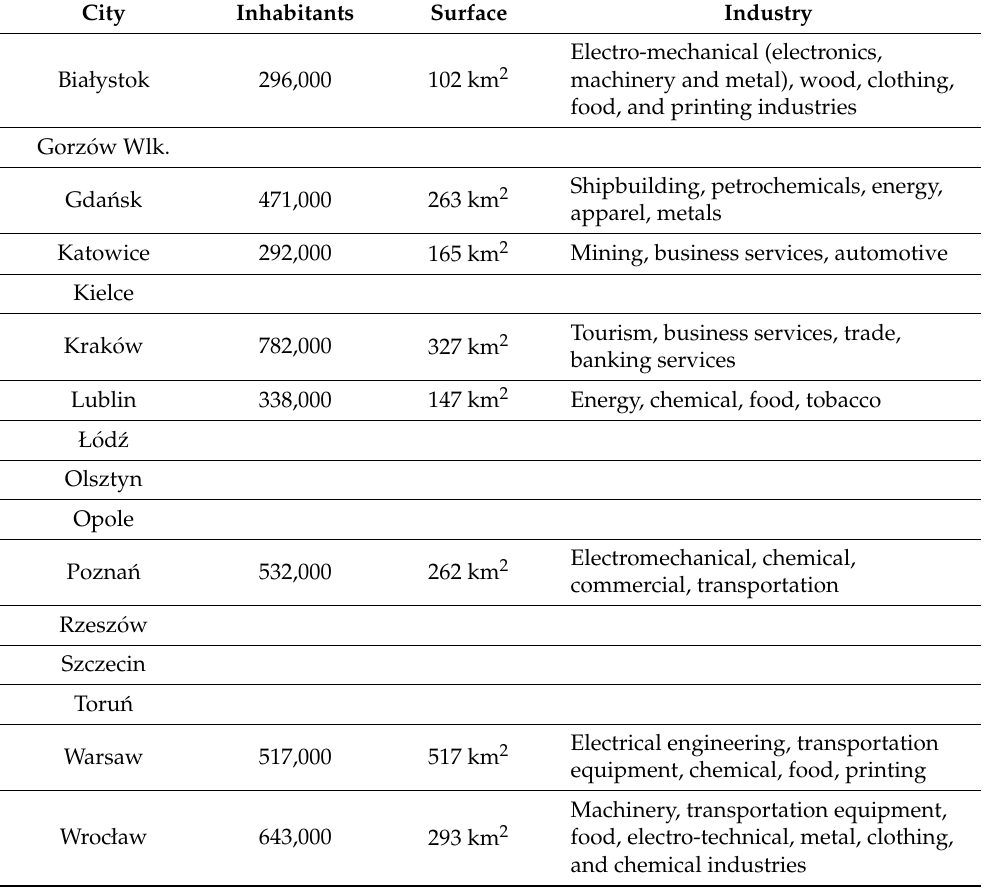
Table 1. Characteristics of the surveyed